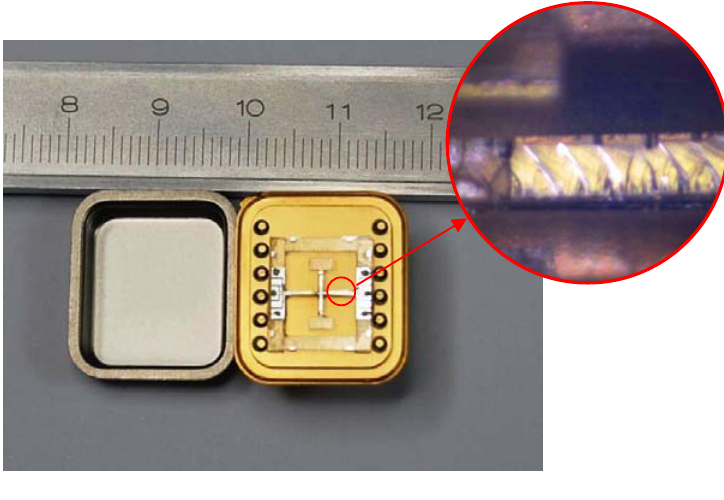
Figure 11. The photo of the prototype